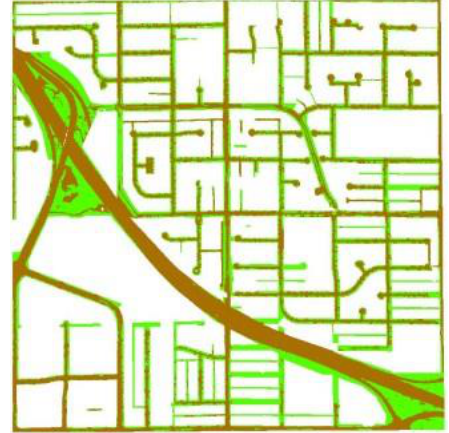
Figure4. Example test area classification using SAM (green- pervious, brown-impervious)